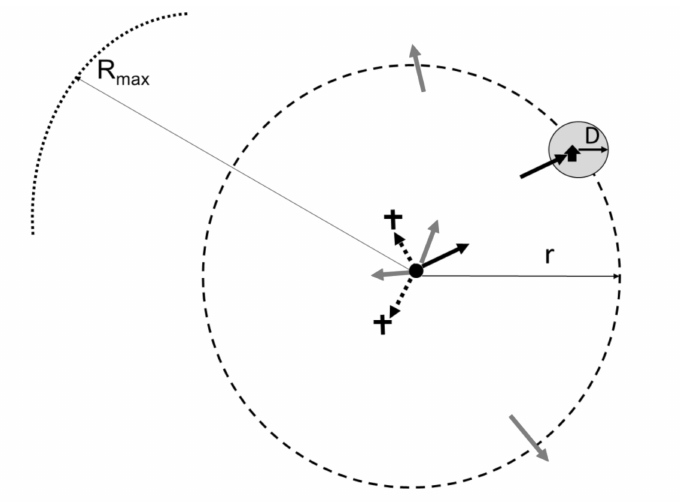
Figure 4. Outflux of insects through an imaginary circular boundary of radius r >> D surrounding the release point (black circle in the middle). Not every released male (indicated by five arrows at the center) reaches the boundary (solid black arrow)—some trajectories terminate (dotted arrows and crosses) inside the circle, while some trajectories continue outside the circle (grey arrows). Of those that do reach the boundary at r (solid black arrow), the fraction caught by the trap is the fraction of the total insect flux through the circle of radius D (plume